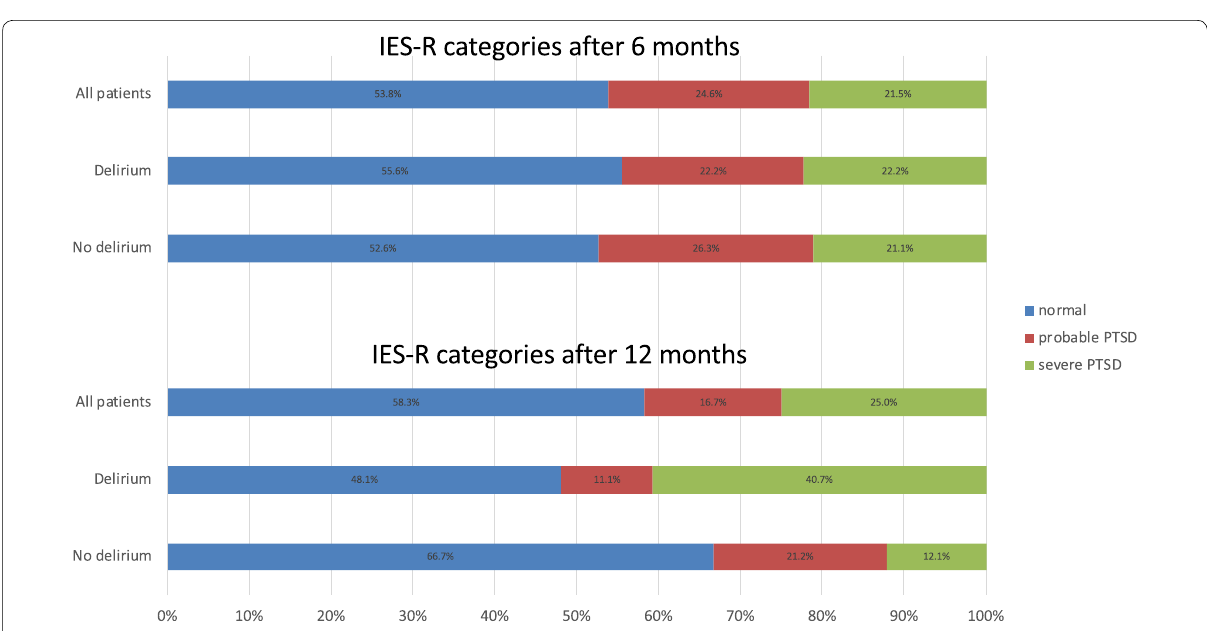
Fig. 4 Frequency distribution of PTSD severity (IES-R) after 6 and 12 months in all patients, and in patients with and without delirium during ICU